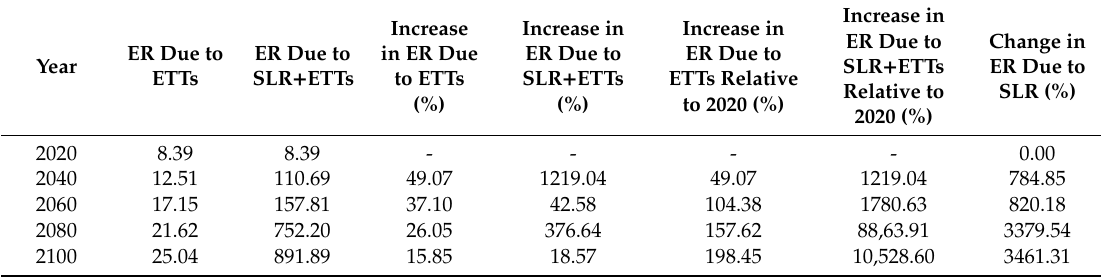
Table 8. Comparison of Economic Risks (ER) at Cairo due to Earthquake Triggered Tsunami (ETTs) and Sea Level Rise